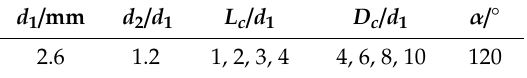
Figure 1. ( a ) Profile and ( b ) photo of HSEOW nozzles. Table 1. Structure parameters of nozzles